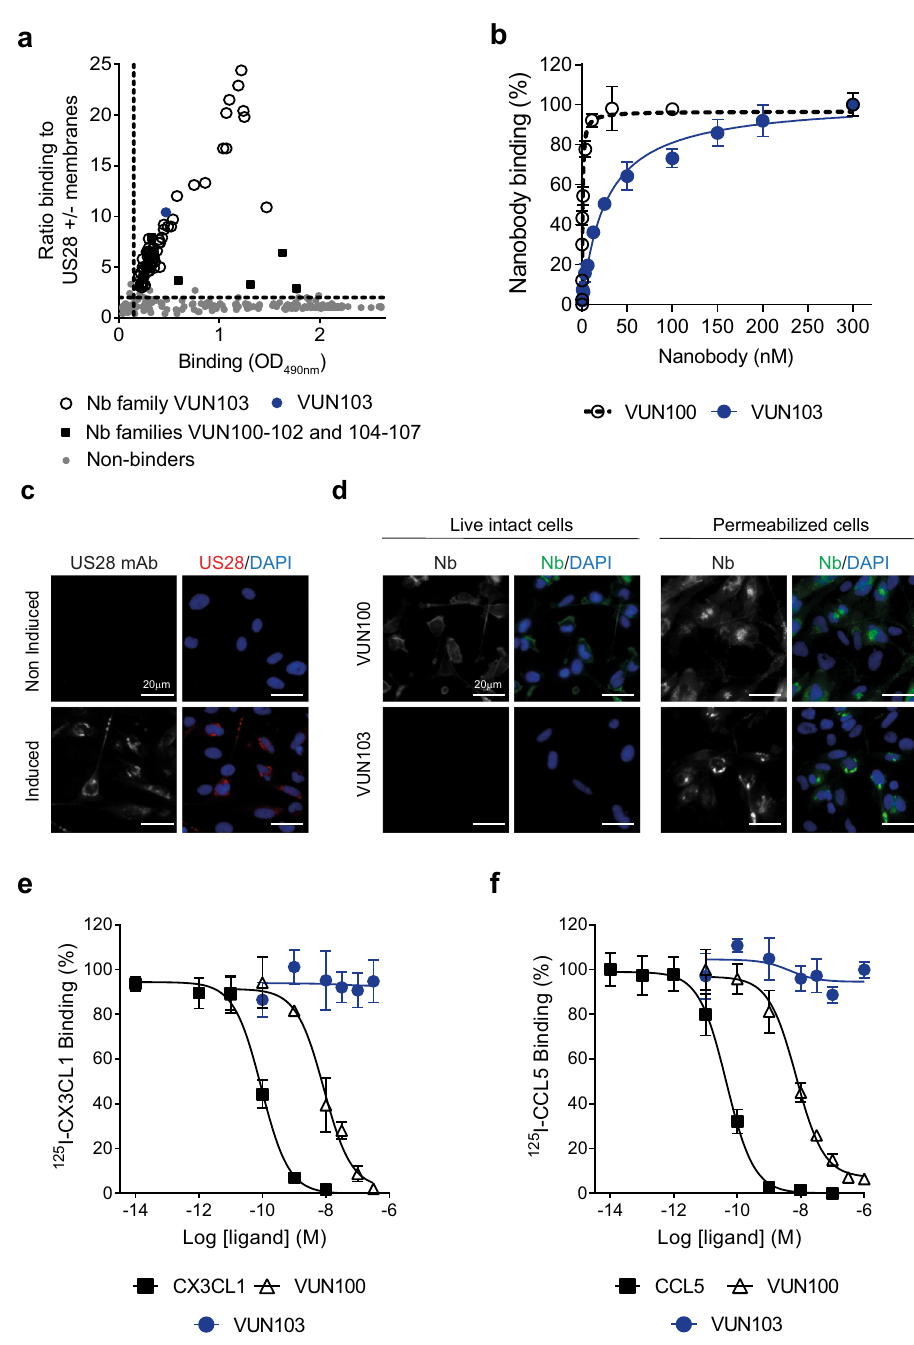
Fig. 1 VUN103 recognizes an intracellular epitope of US28. a Binding of nanobody-expressing phage, after selection on US28, to US28 measured by phage ELISA. The ratio of binding of phage to membranes with or without US28 was determined and plotted against the total binding of phages to US28- expressing membranes. Data represent one independent experiment. b Binding of the nanobodies VUN100 and VUN103 to US28-expressing membranes, as determined by ELISA. Binding was normalized to binding to US28-negative membranes to determine speci fi c binding ( n = 3 independent experiments). c Staining of US28 after 48 h of doxycycline-induction of US28-expressing U251 cells. Non-induced US28-expressing U251 cells served as negative control. Cells were fi xed and permeabilized before US28 was visualized using a conventional anti-US28 antibody (US28 mAb; US28, red) and nuclei were stained with DAPI. Representative data of three independent experiments. d Binding of VUN100 and VUN103 to live, intact (non-permeabilized) and fi xed and permeabilized US28-expressing U251 cells. For live cells, nanobodies were incubated with cells on ice before cells were fi xed. For permeabilized cells, cells were fi xed and permeabilized before incubation with nanobodies. Nanobody binding was detected using the Myc-tag and an anti-Myc antibody (Nb, green) and nuclei were stained with DAPI. Representative data of three independent experiments. e , f Displacement of 125 I- CX3CL1 ( c ) and 125 I-CCL5 ( d ) from different US28-expressing membranes by unlabeled ligand (CX3CL1, CCL5, VUN100 or VUN103) ( n = 3 independent experiments). All are plotted as mean ± SD. Source data are provided as a Source Data fi